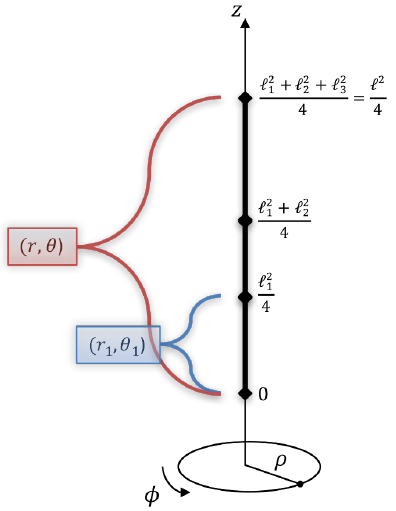
Figure 1 . Schematic description of connected rod sources on the z -axis. We depict the local spherical coordinates on the first rod, ( r ) (3.4), and the global spherical coordinates on the 1 , θ 1 whole configuration, ( r, θ )